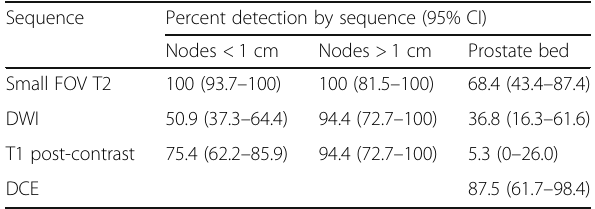
Table 4 Detection rates by MRI sequence for abdominopelvic lymph node correlates to PSMA-positive